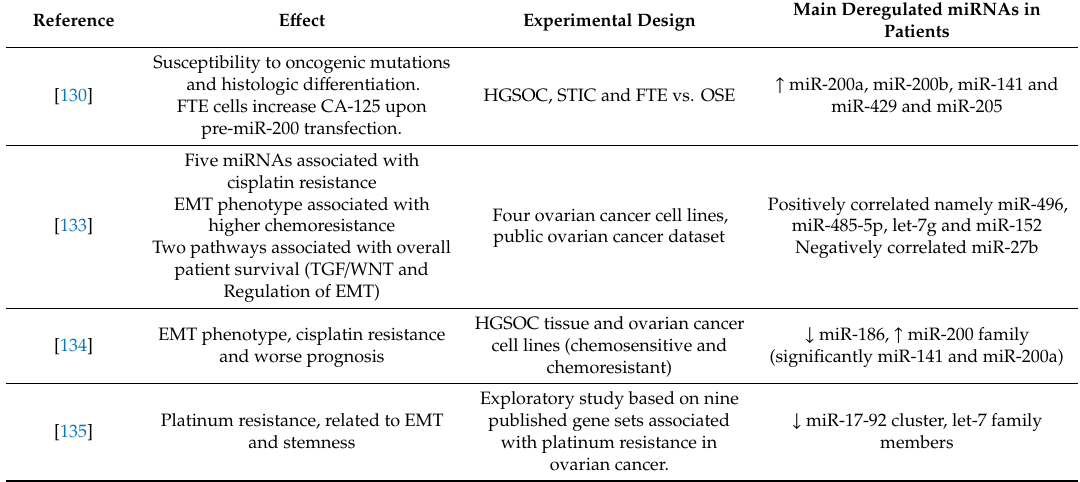
Table 4. Deregulated miRNAs in selected studies in